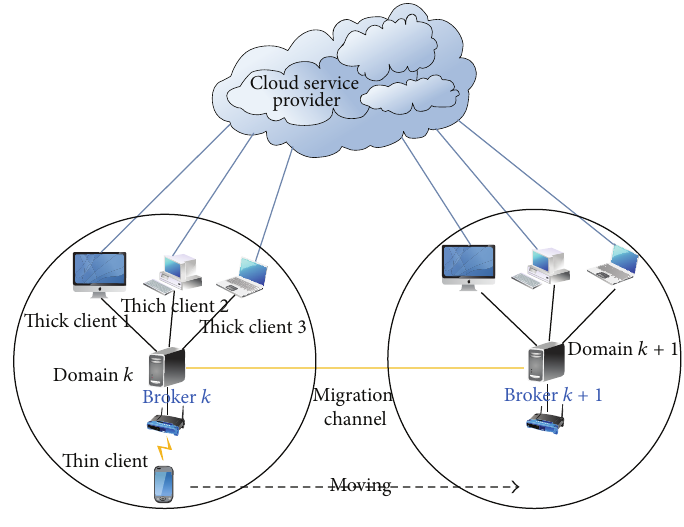
Figure 1: Motivating